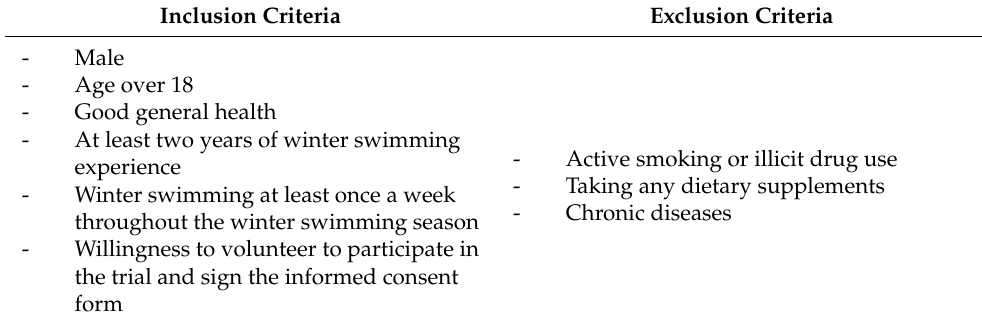
Table 1. Eligibility criteria.